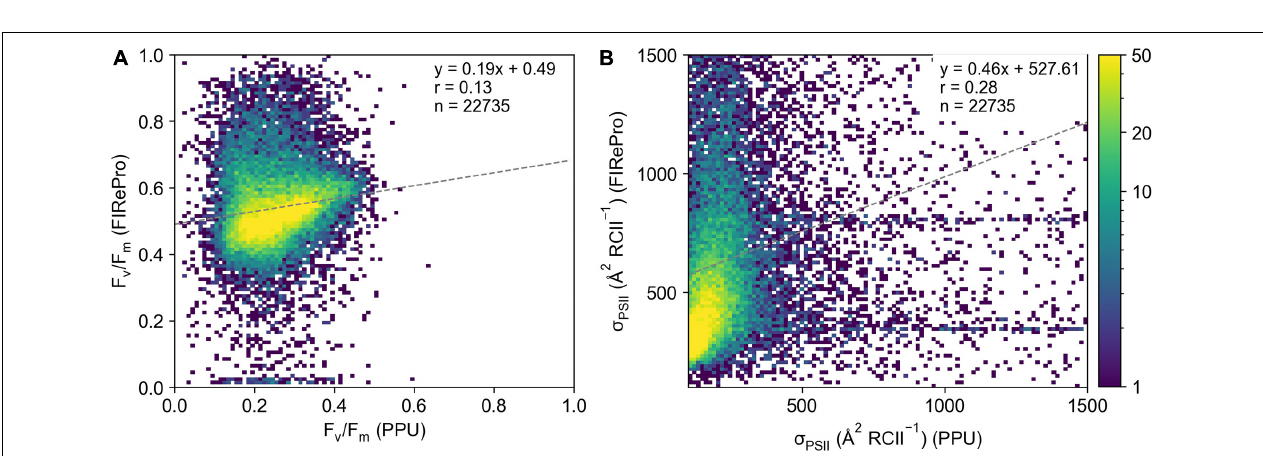
FIGURE 8 | Comparison of (A) F v /F m and (B) σ PSII derived from the FIRePro software (y-axis) and PPU (x-axis). Data is from the Southern Ocean (FIRe, ACE).